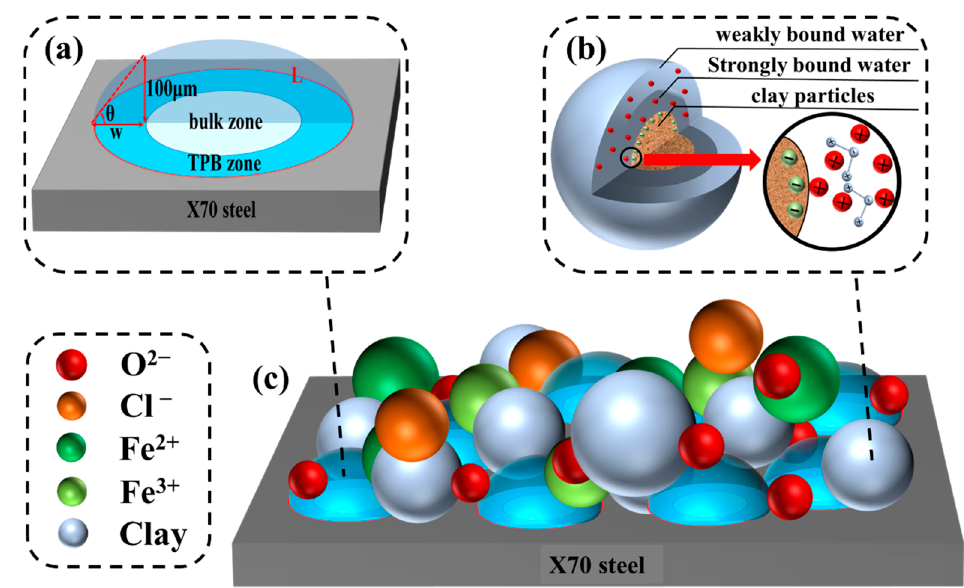
Figure 21. Schematic illustration of interfacial corrosion between X70 steel and chlorine-containing pore solution: ( a ) geometry of the TPB and volumetric region of electrolyte droplets on a flat metal surface, ( b ) cohesive soil particle structure and its ion exchange mode on the metal surface, ( c ) schematic diagram of each ion participating in the reaction on the metal surface.